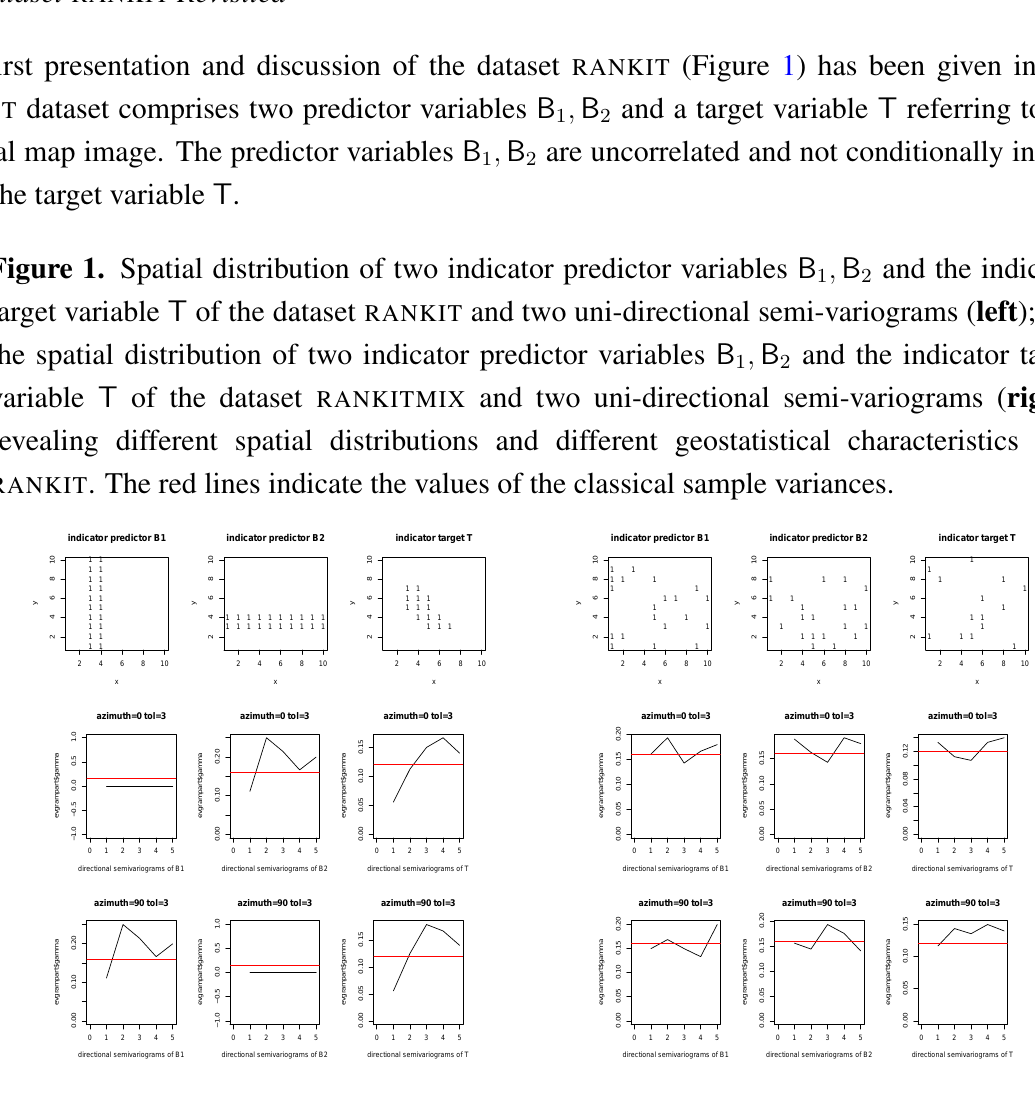
, B and the indicator target 1 2